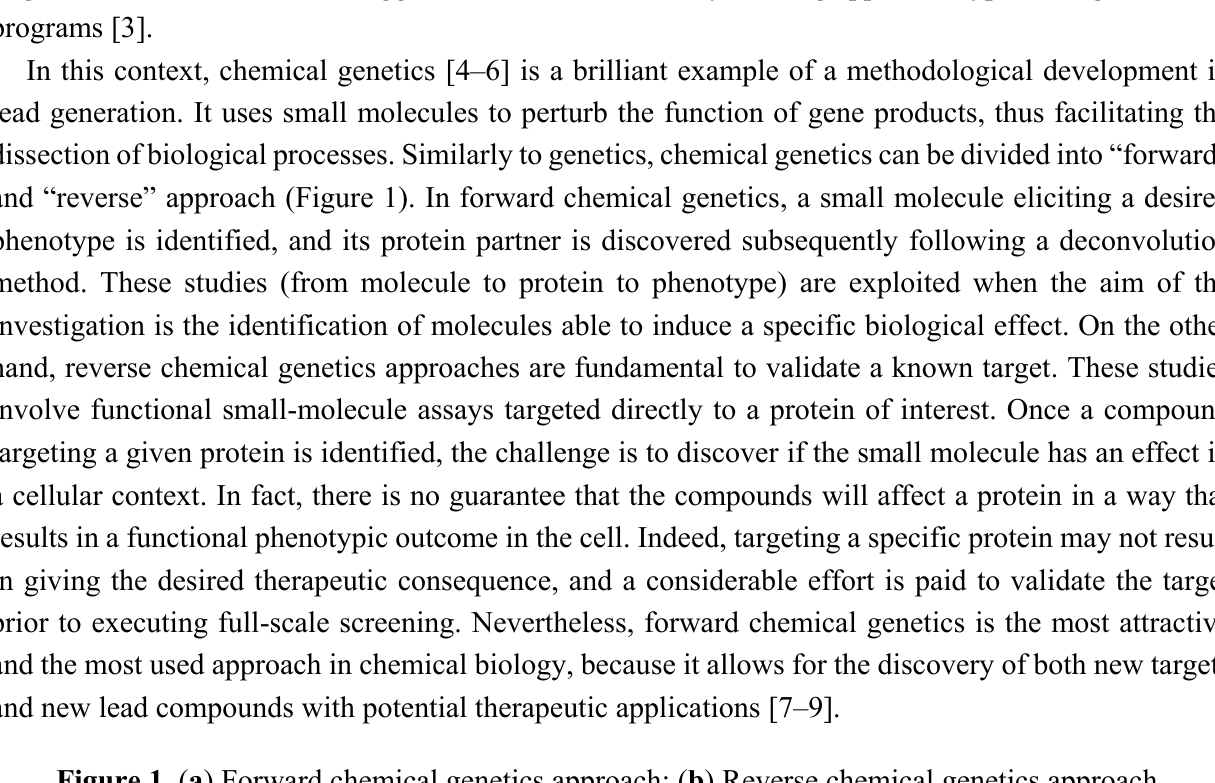
Figure 1. ( a ) Forward chemical genetics approach; ( b ) Reverse chemical genetics